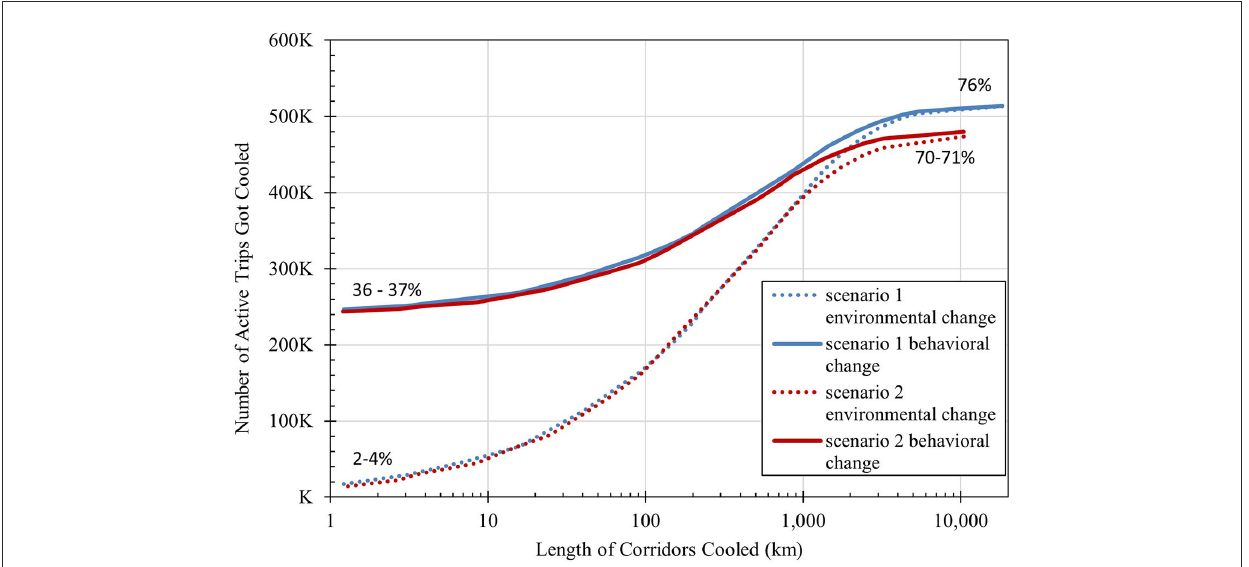
FIGURE3 Number of active trips cooled by environmental and behavioral change. The x-axis represents the total length of the network selected to obtain environment change. The y-axis represents the total number of trips to obtain heat exposure mitigation. The blue lines represent the street’s cooling condition in scenario 1 where the roadways’ temperature is reduced to the lowest 10%. The red lines represent the street’s cooling condition in scenario 2 where the roadways’ temperature is reduced to the lowest 50%.